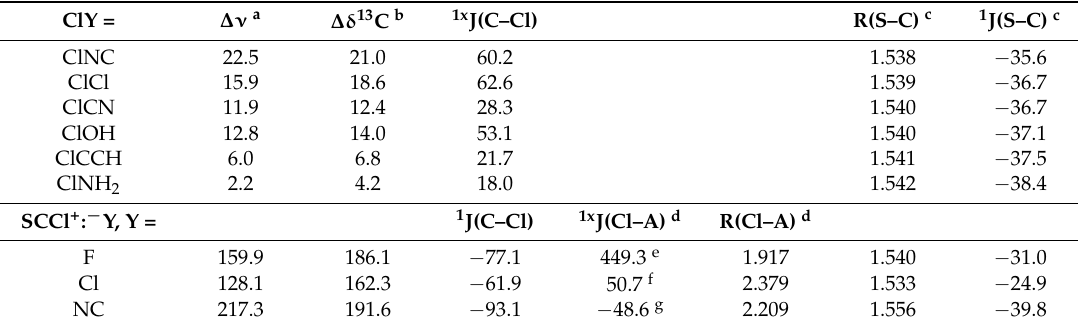
Table 4. Increases in C–S stretching frequencies ( δν , cm − 1 ) and 13 C chemical shieldings ( ∆ δ 13 C, ppm), Cl–A and S–C distances (Å), and coupling constants 1x J(C–Cl), 1x J(Cl–A), 1 J(C–Cl) and 1 J(S–C) (Hz) for SC:ClY